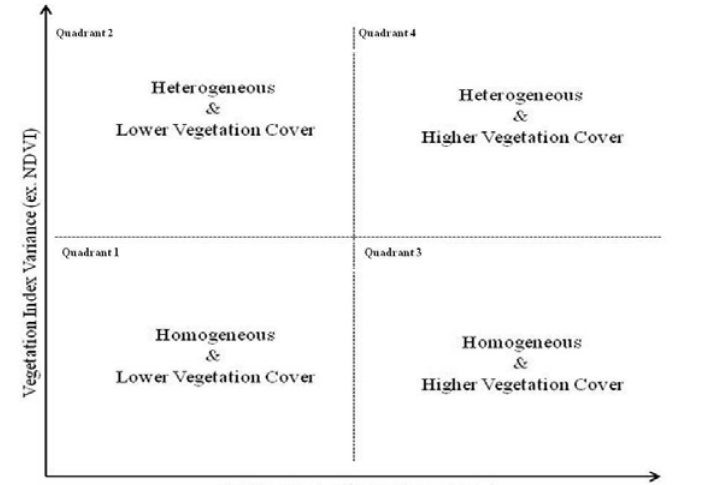
Figure 4. Hypothetical relationship between mean-variance and vegetation status, adapted from Washington-Allen et al.